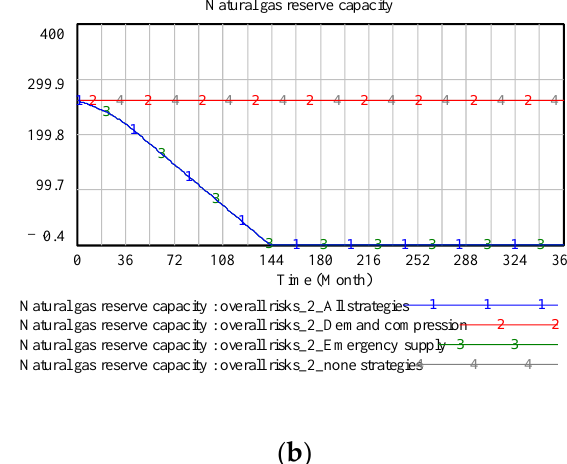
Figure 6. Effects of the risk response strategies: ( a ) the behavior of the coupled markets’ satisfaction rate for different risk response strategies; ( b ) the behavior of the capacity of natural gas reserves for different risk response strategies.